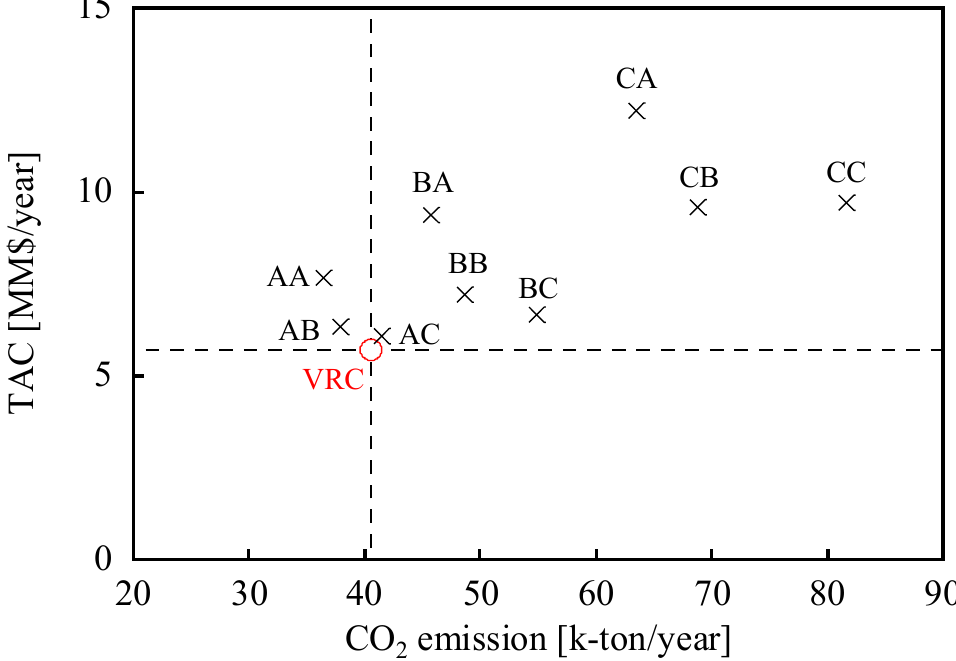
Figure 7. The relationship between CO 2 emissions and TACs. O: VRC, ×: membrane-separation process using the current membranes.